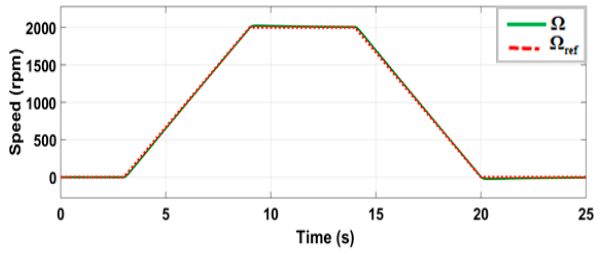
Figure 11. Motor speed and reference with EQZSI.